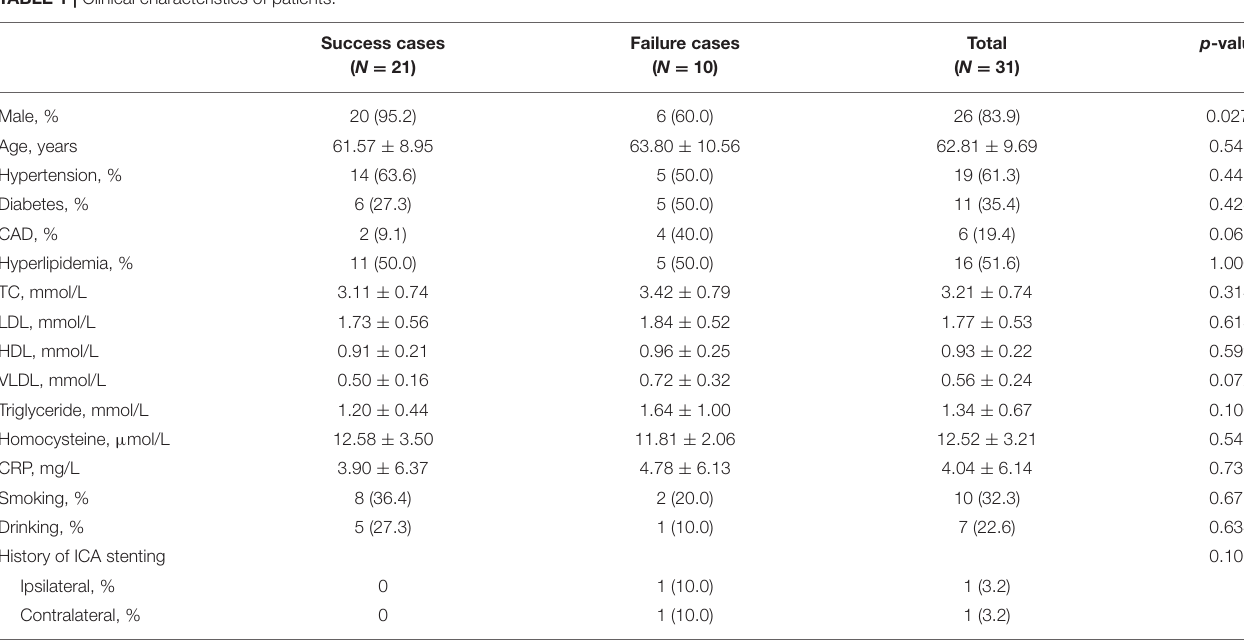
FIGURE 1 | A typical example of C1-C7 diameter measurements in the axial image by HRVWI of ICAO patients. High-resolution vessel wall magnetic resonance imaging (HRVWI) examination with contrast before the procedure. C0, common carotid artery; C1, cervical; C2, petrous; C3, lacerum; C4, cavernous; C5, clinoidal; C6, ophthalmic; and C7, communicating segment of internal carotid artery. TABLE 1 | Clinical characteristics of